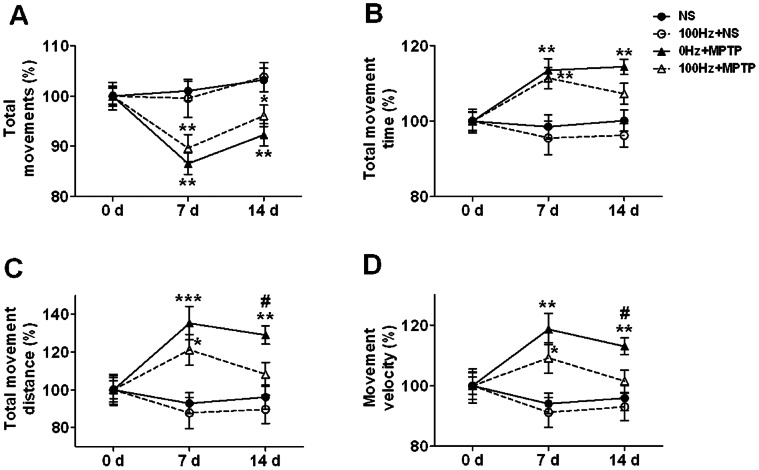
100 Hz EA stimulation improves the hyperkinesia of MPTP mice.(A) Total movements. (B) Total movement time. (C) Total movement distance. (D) Movement velocity. Filled circle with solid line represents the NS group, hollow circle with dash line represents the 100 Hz+NS group, filled triangle with solid line represents the 0 Hz+MPTP group, and hollow triangle with dash line represents the 100 Hz+MPTP group. *p<0.05, **p<0.01, ***p<0.001 vs. NS group on the same day; #
p<0.05 vs. 100 Hz+MPTP group on the same day. n = 12∼14.